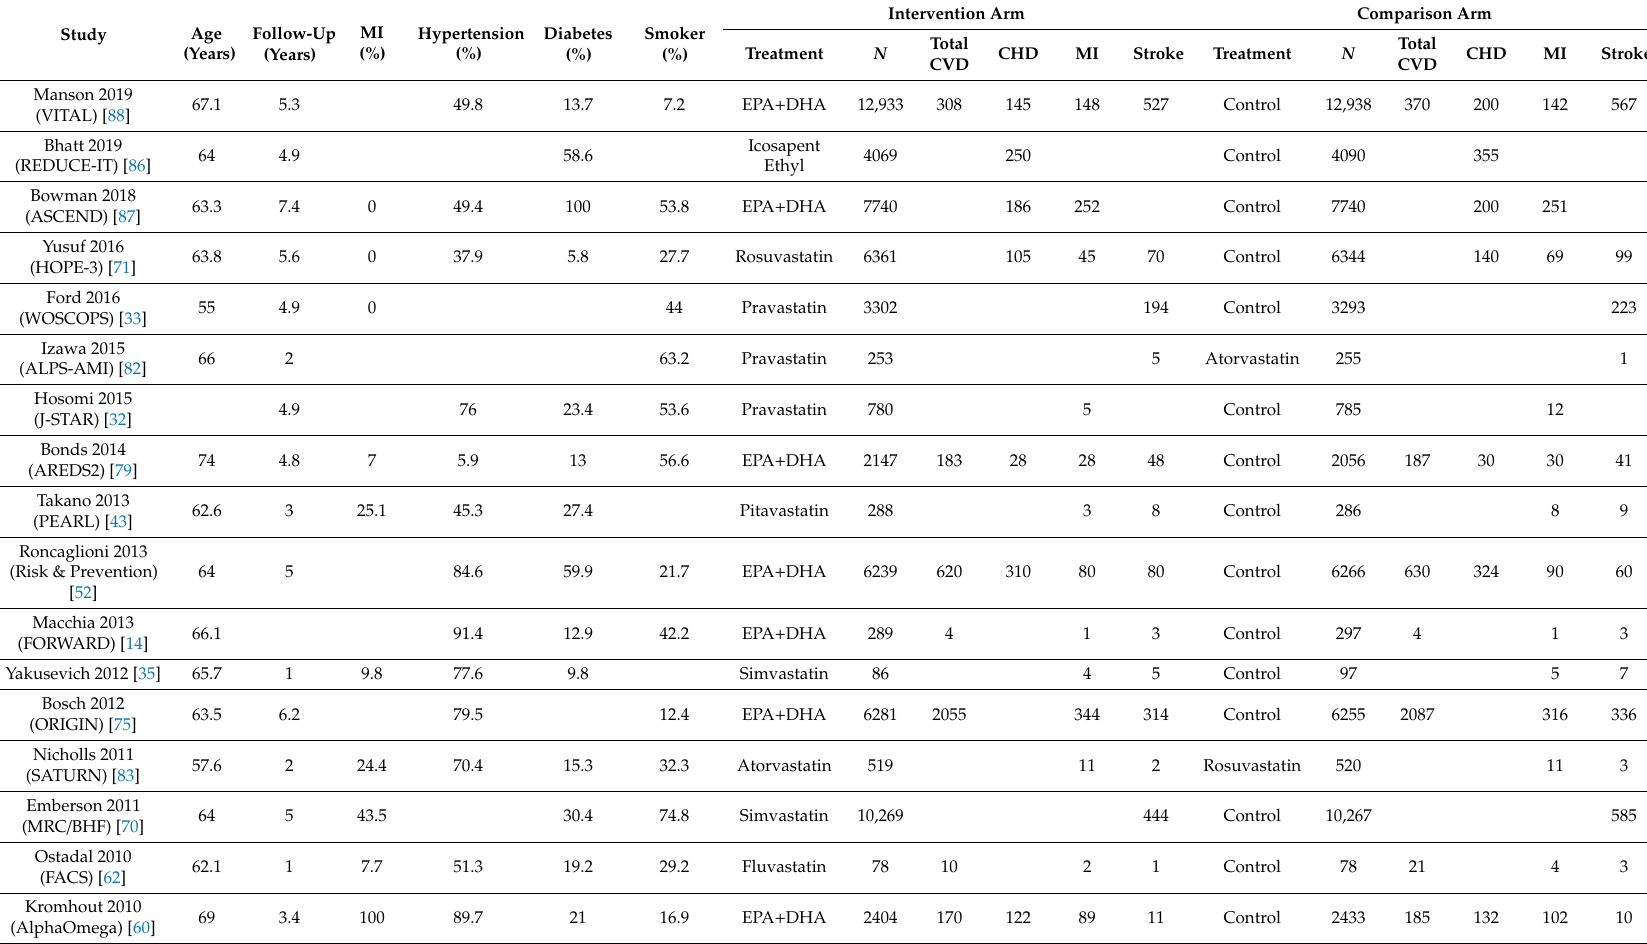
Table 1. Characteristics of trials included in the final